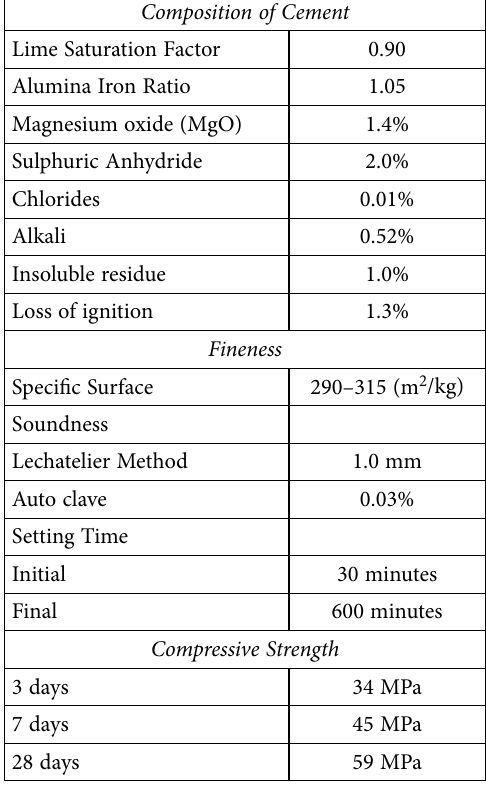
Table 1. Properties of cement